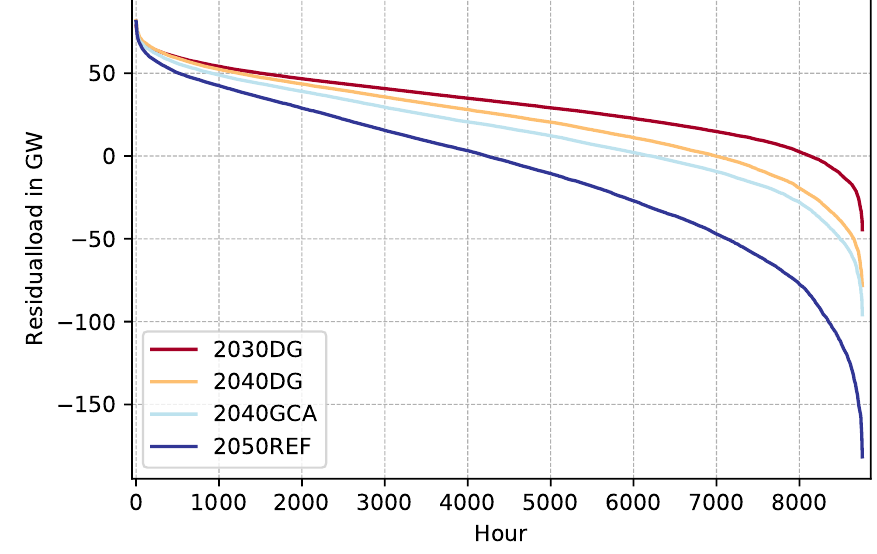
Figure A1. Electrical residual load in Germany within all main